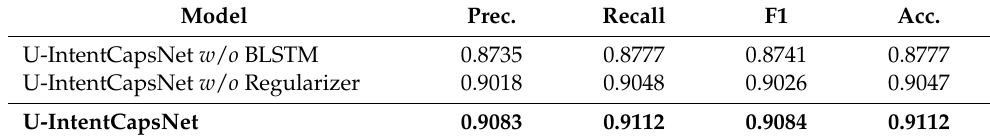
Table 15. Intent detection results for the proposed U-IntentCapsNet model in ablation experiments. Model